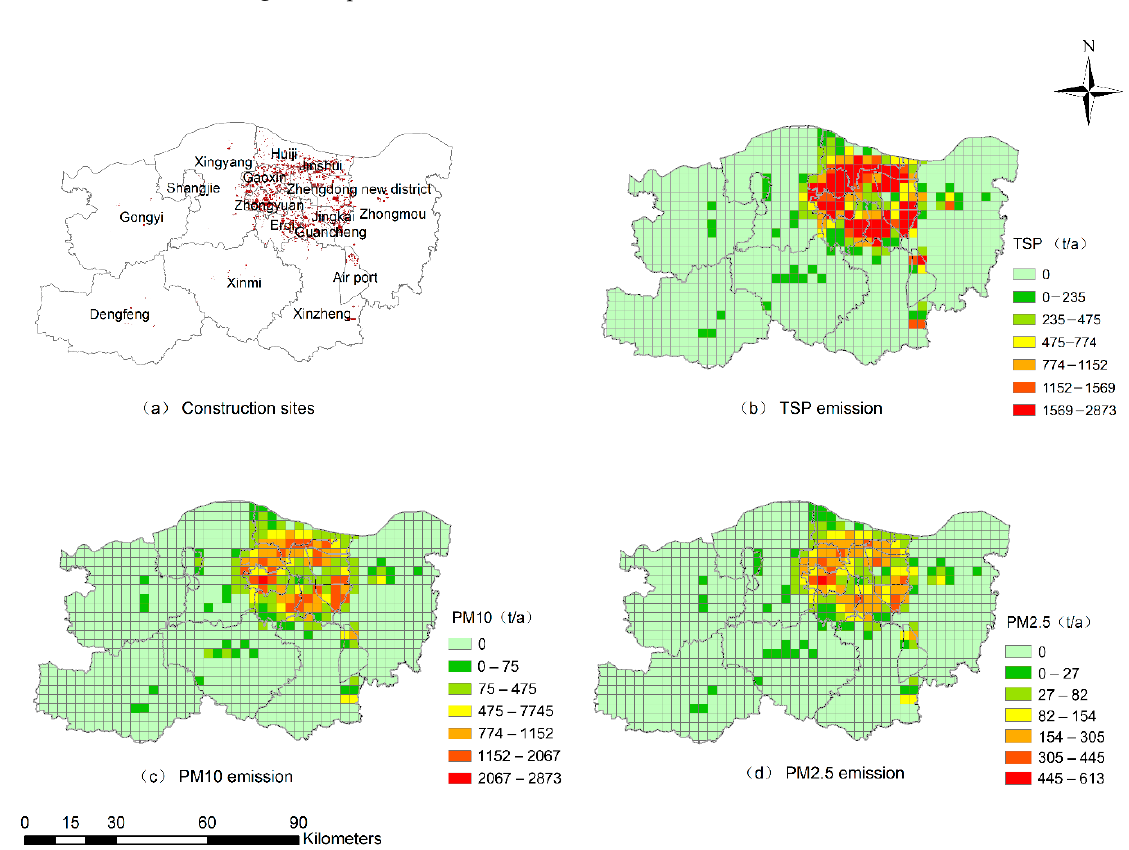
Figure 4. Spatial distribution of PM emission from construction dust source.